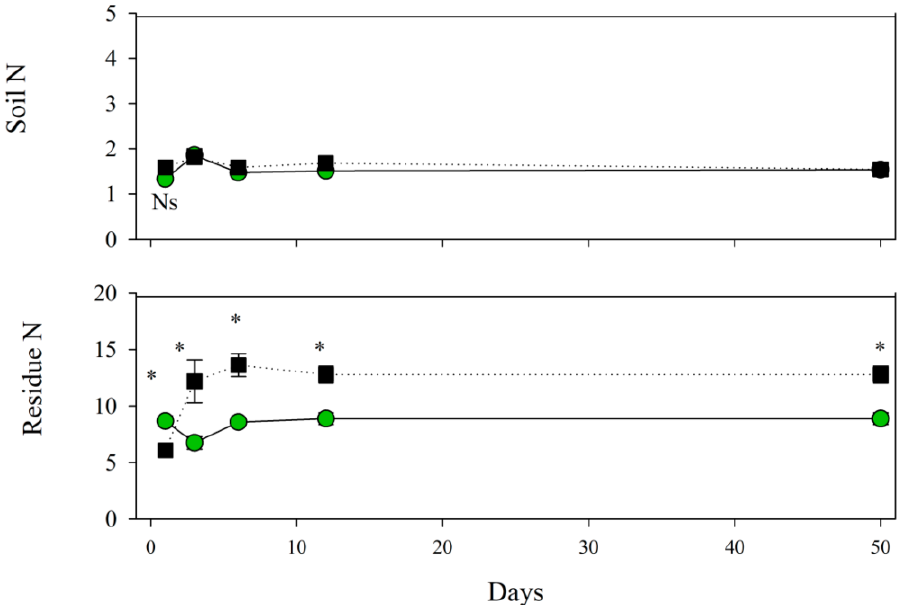
Figure 2. Daily total organic carbon and nitrogen in residue and soil (g kg − 1 ) during 50 days of incubation. The mean of high and low C:N was compared by the t test ( p < 0.05); * and Ns mean significant difference and no difference between residues, respectively. The variables were monitored on the 1st, 3rd, 6th, 12th, and 50th day of incubation.